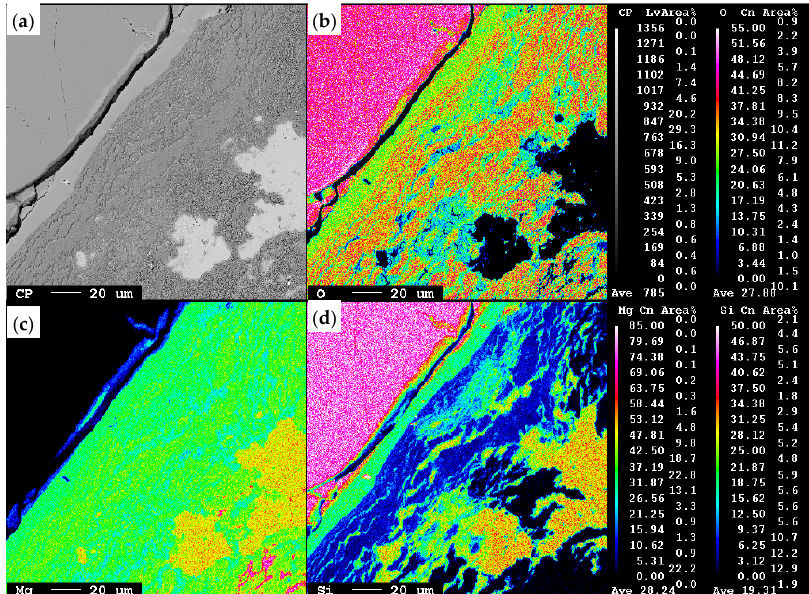
Figure 3. ( a ) Backscattered electron image of the interface between SiO 2 and products of the sample at a Mg/SiO 2 mole ratio of 4, 173 K temperature and 20 min reaction time; ( b ) X-ray mapping of O; ( c ) X-ray mapping of Mg; ( d ) X-ray mapping of Si.